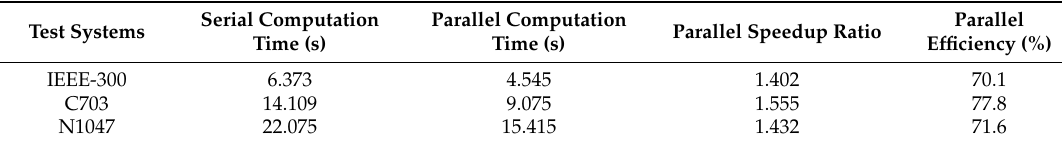
Table 3. Parallel Performance of the Traditional PLF Algorithm.